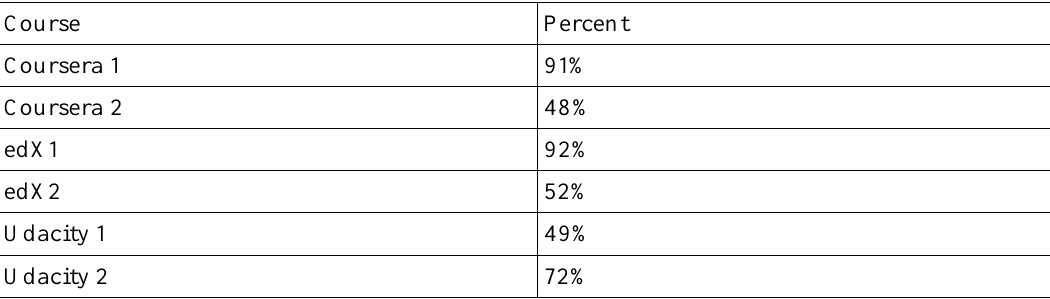
Quality Matters Results Without Standard